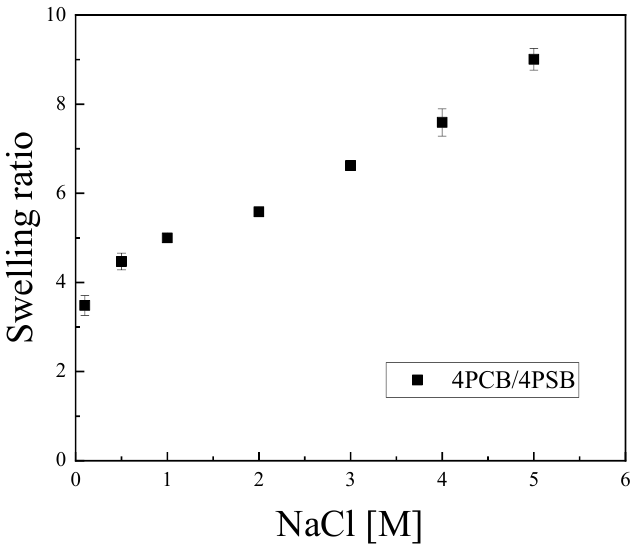
Figure 4. Swelling ratio of PCB/PSB IPN hydrogel in NaCl aqueous solutions with different concentrations at 25 °C.